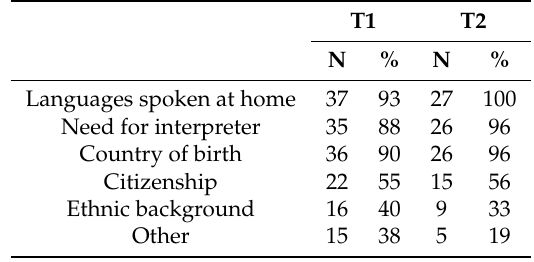
Table 7. Frequency data on organisations collecting data on ethnicity-related variables.